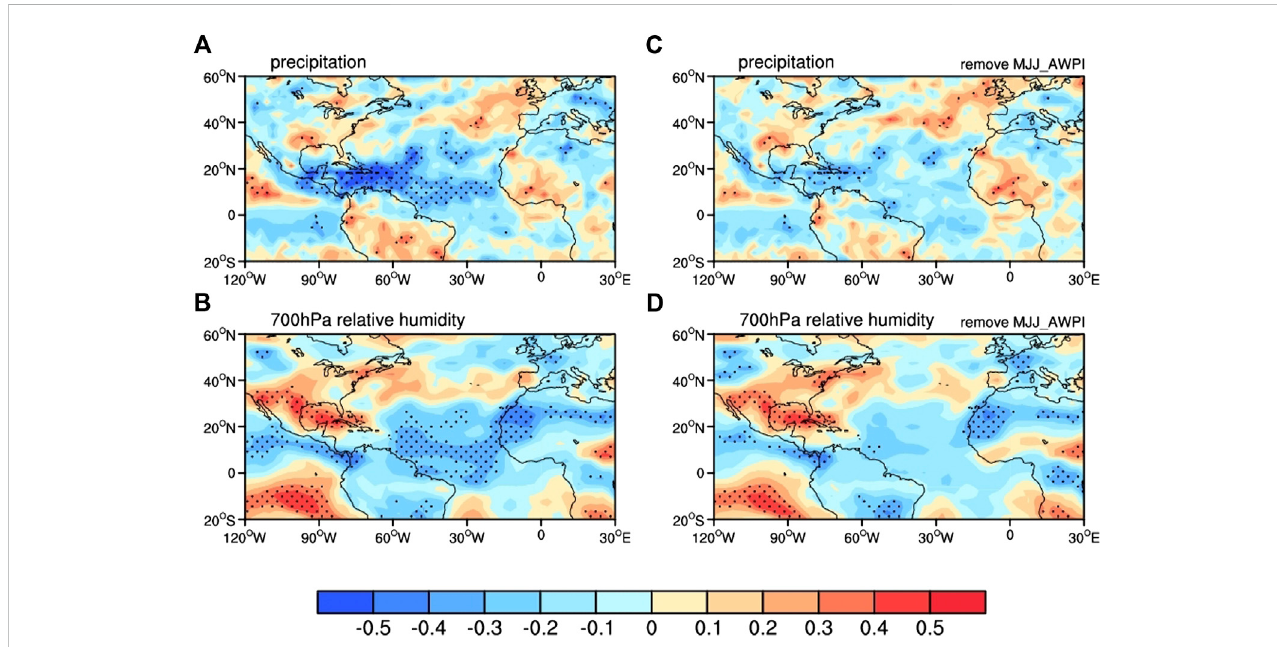
FIGURE 14 (A, B) Correlation map of the summer (the JJA season) precipitation (units: mm/d) and 700 hPa relative humidity anomalies with the DJFM-averaged NADI. (C, D) as in (A, B) but for the DJFM-averaged NADI linearly removing the following MJJ AWPI.